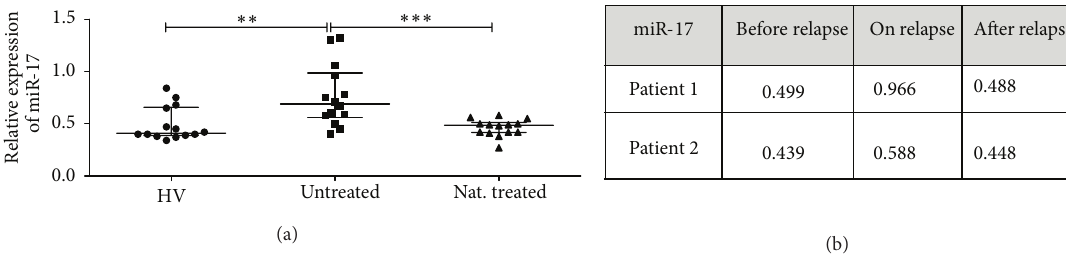
Figure 1: miR-17 differential expression in CD4 + T cells of HV and RRMS patients. Transcriptional expression of miR-17 was analyzed with real-time RT-PCR in CD4 + T cells from (a) HVs and untreated and natalizumab treated patients ( 𝑛 = 14 ) (bars represent median with interquartile range); (b) two patients on natalizumab therapy who experienced relapse (before, on, and after relapse time points). Relative expression levels are depicted. One-way ANOVA with Tukey’s multiple comparison test was applied. ∗∗∗ 𝑃 < 0.001 ; ∗∗ 𝑃 < 0.01 .